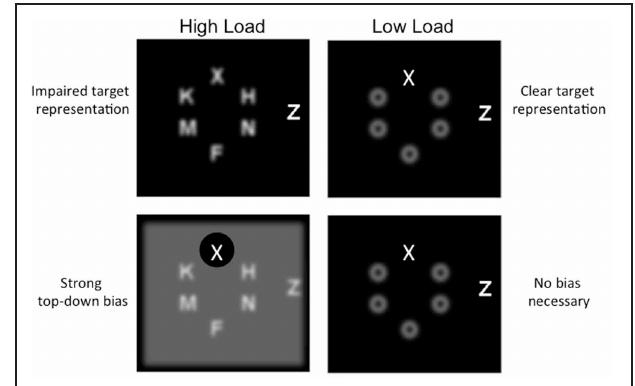
FIGURE 1 | Schematic depiction of the consequences of competition and top–down bias. Under high load, competition impairs target representation ( top panel) and thus a top–down bias is necessary to resolve the target (bottom) , which in turn filters out the distractor. Under low load, the target representation is already clear ( top panel) and thus no bias is needed to perform the task ( bottom panel).